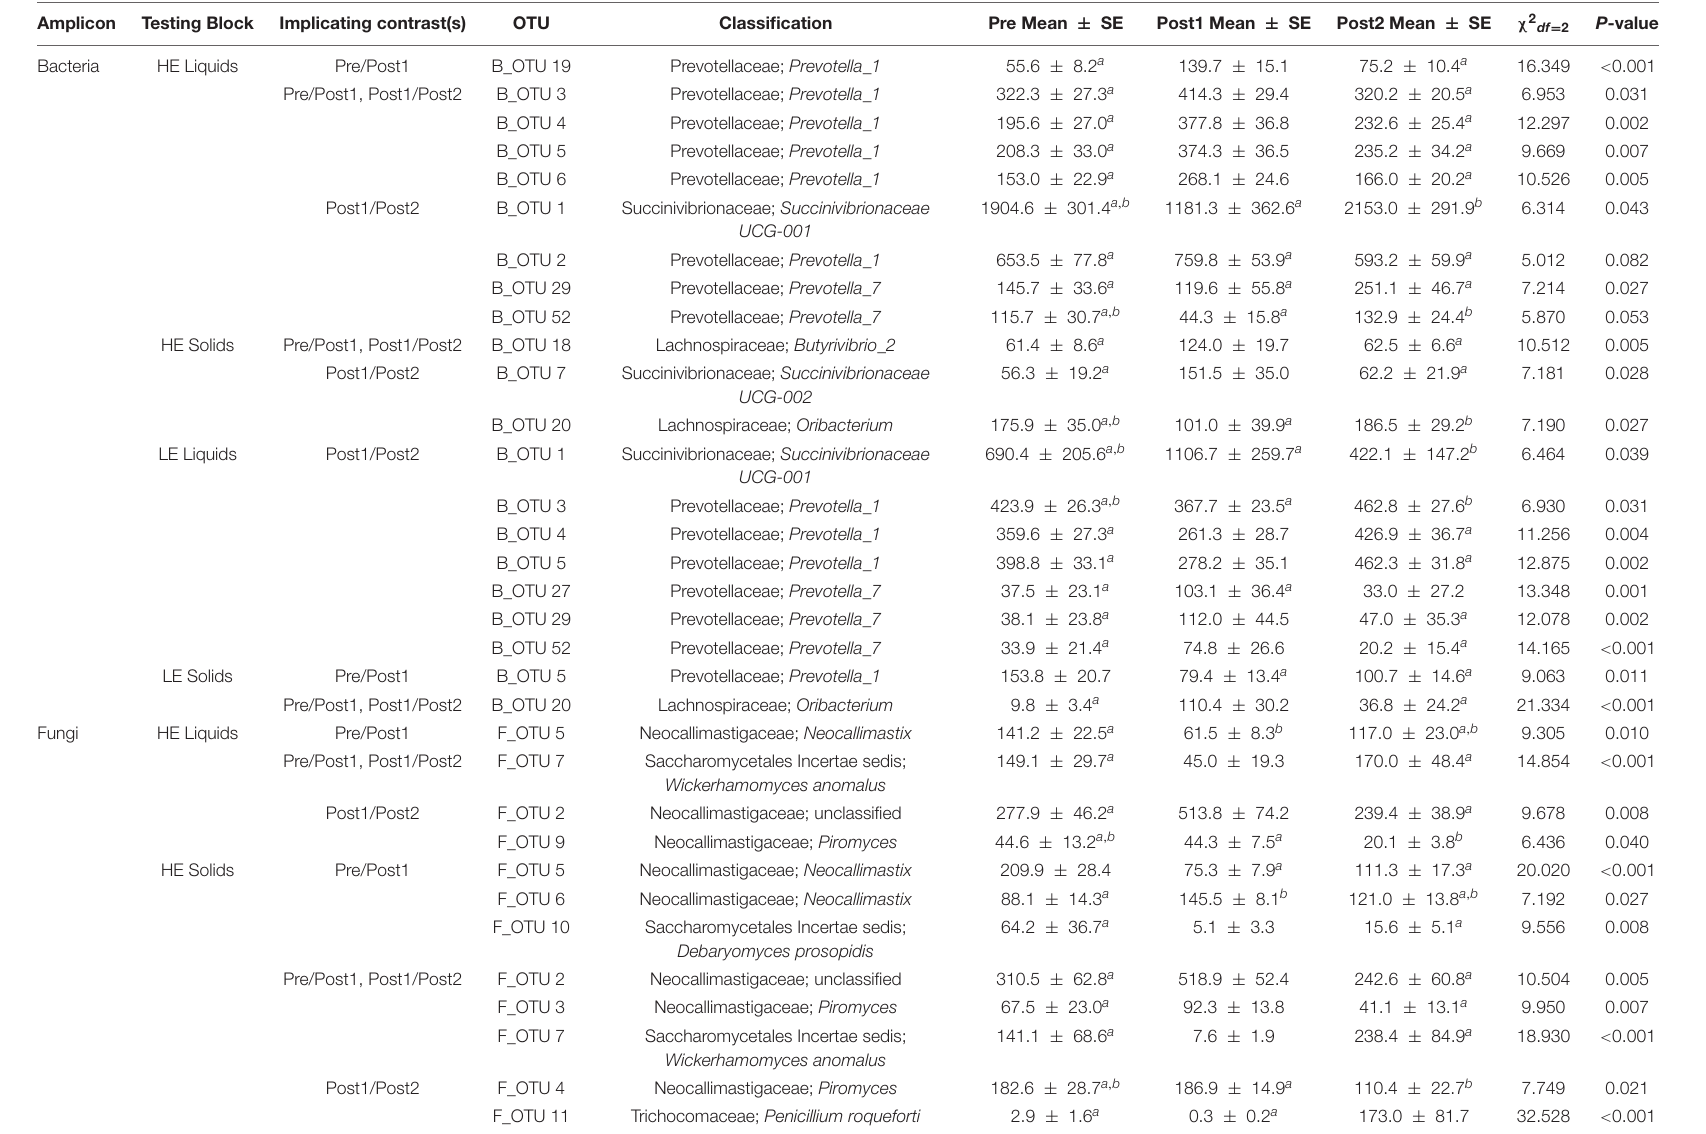
TABLE 2 | Kruskal-Wallis tests of SIMPER-implicated